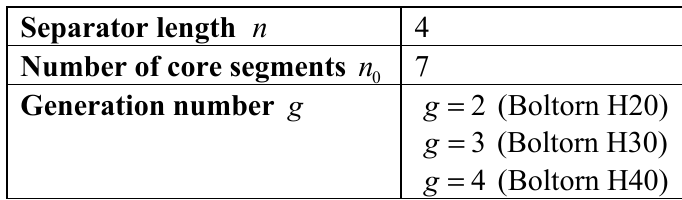
Table 4. Architectural parameters describing hyperbranched polyester